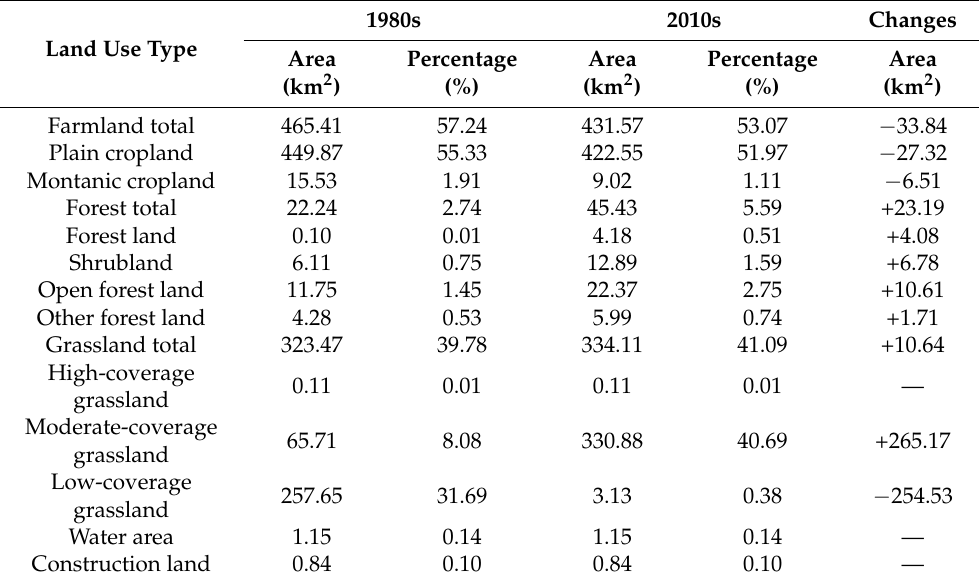
Table 1. Major land uses and their changes in the Xiaolihe watershed from the 1980s to 2010s.